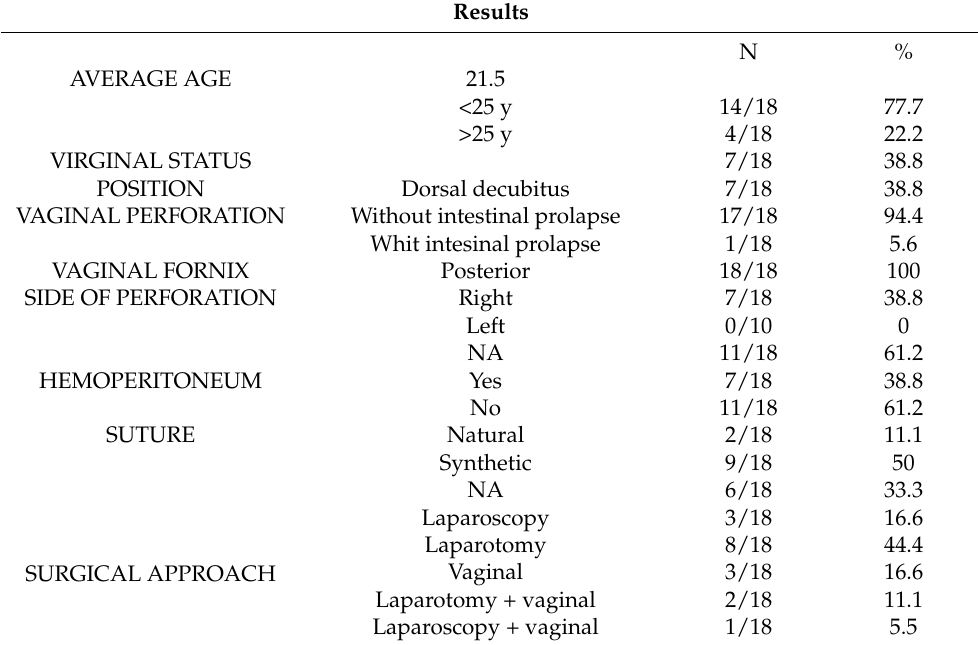
Table 2. Review results Legends: NA—Not